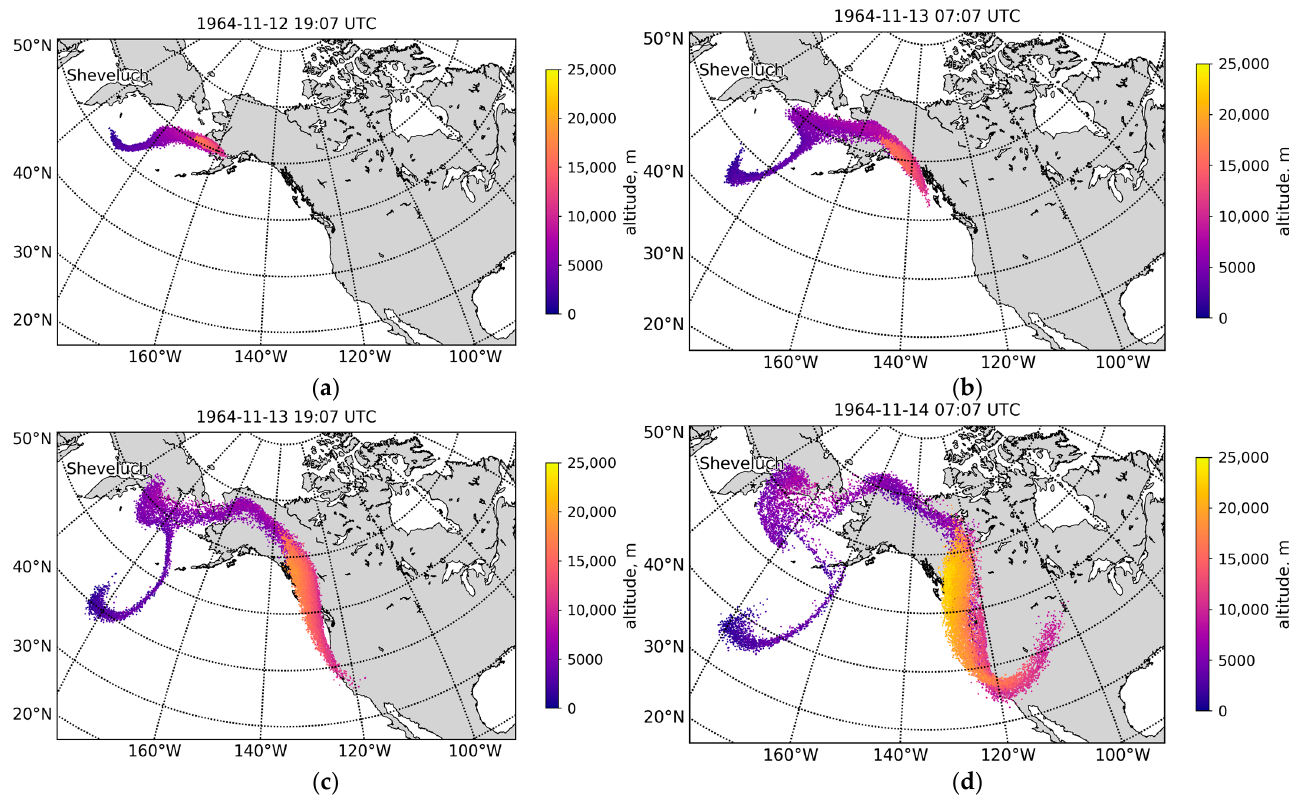
Figure 13. The visualization of the modeling results for the Sheveluch eruptive cloud as of: ( a ) 19:07 UTC, 12 November; ( b ) 07:07 UTC, 13 November; ( c ) 19:07, 13 November; ( d ) 07:07, 14 November.